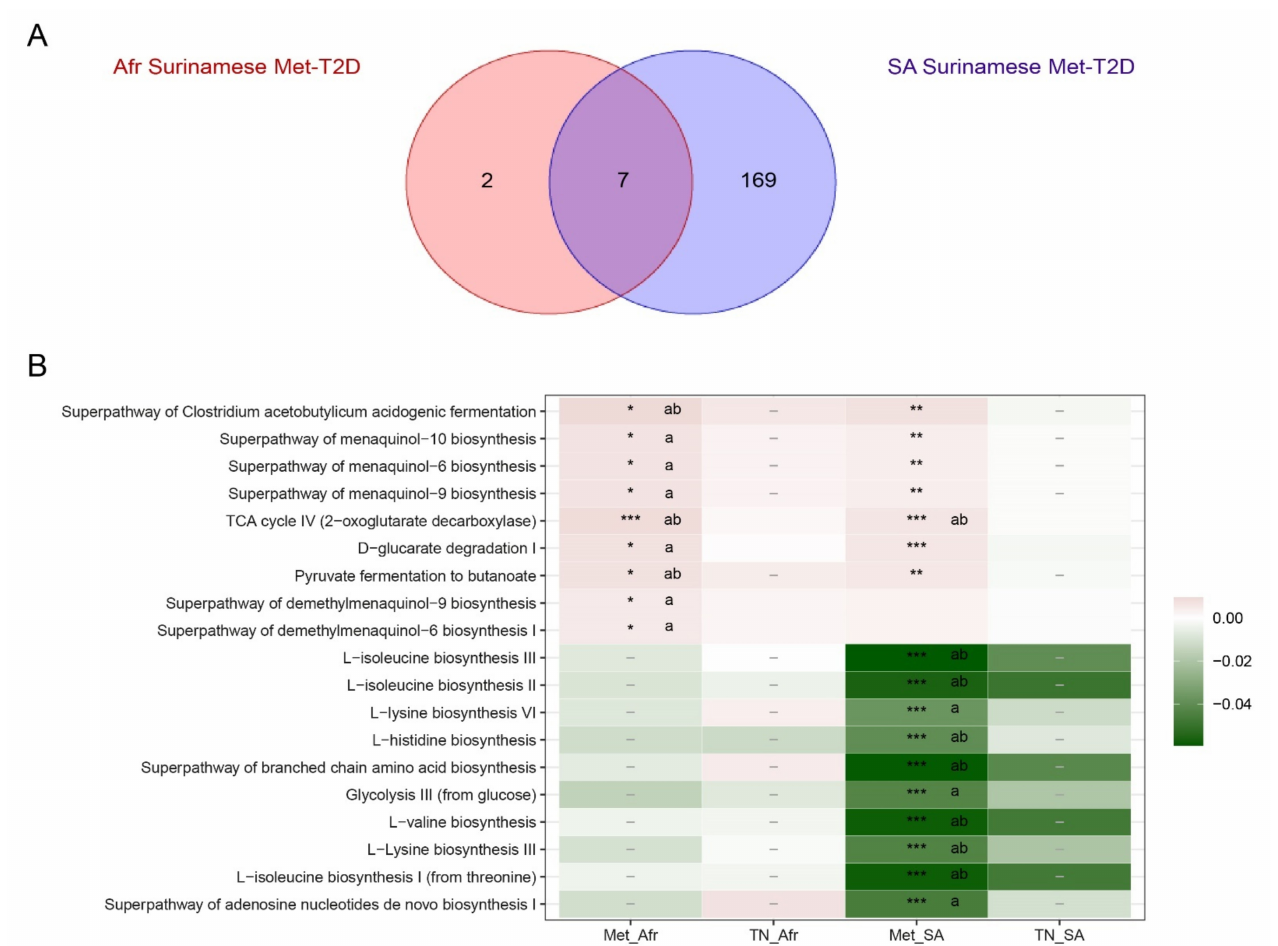
Figure 5. Overview of significant pathways in the Wilcoxon analysis. ( A ) Overlap in significant pathways with the Wilcoxon analysis after correction for multiple testing, without adjusting for confounders, in African Surinamese and South-Asian Surinamese in the Met-T2D datasets (Met-T2D cases and matched controls). ( B ) Overview of the most significant pathways selected by Wilcoxon analysis according to T2D status in both ethnicities. Significant pathways after correction for multiple comparison are indicated with a *. * p ≤ 0.05, ** p ≤ 0.01, *** p ≤ 0.001, not significant pathways are indicated with a -, no symbol indicates the pathway was filtered out before the analysis was applied. Color of each pathway indicates the difference in median relative abundance (in %) for this pathway. Green indicates a lower median relative abundance of the pathway in T2D cases compared to their matched healthy controls, red indicates a higher median relative abundance of the pathway in T2D cases compared to their matched healthy controls and white indicates an equal median relative abundance of the pathway in both T2D cases and their matched healthy controls. Only significant pathways were tested with a linear regression model, using log-transformed relative abundances of the pathways as dependent variable, to adjust for (a) age, sex and BMI or (b) age, sex, BMI and use of PPI, statins, beta blockers or medication working on the renin-angiotensin system. Significant pathways after adjustment are indicated with the corresponding character. Met_Afr = Met-T2D dataset (Met-T2D cases and matched controls) for African Surinamese, TN_Afr = TN-T2D dataset (TN-T2D cases and matched controls) for African Surinamese, Met_SA = Met-T2D dataset (Met-T2D cases and matched controls) for South-Asian Surinamese and TN_SA = TN-T2D dataset (TN-T2D cases and matched controls) for South-Asian